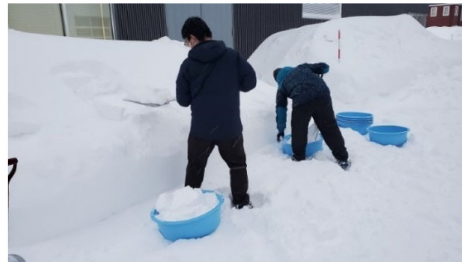
Figure 18. Process of snow collection.